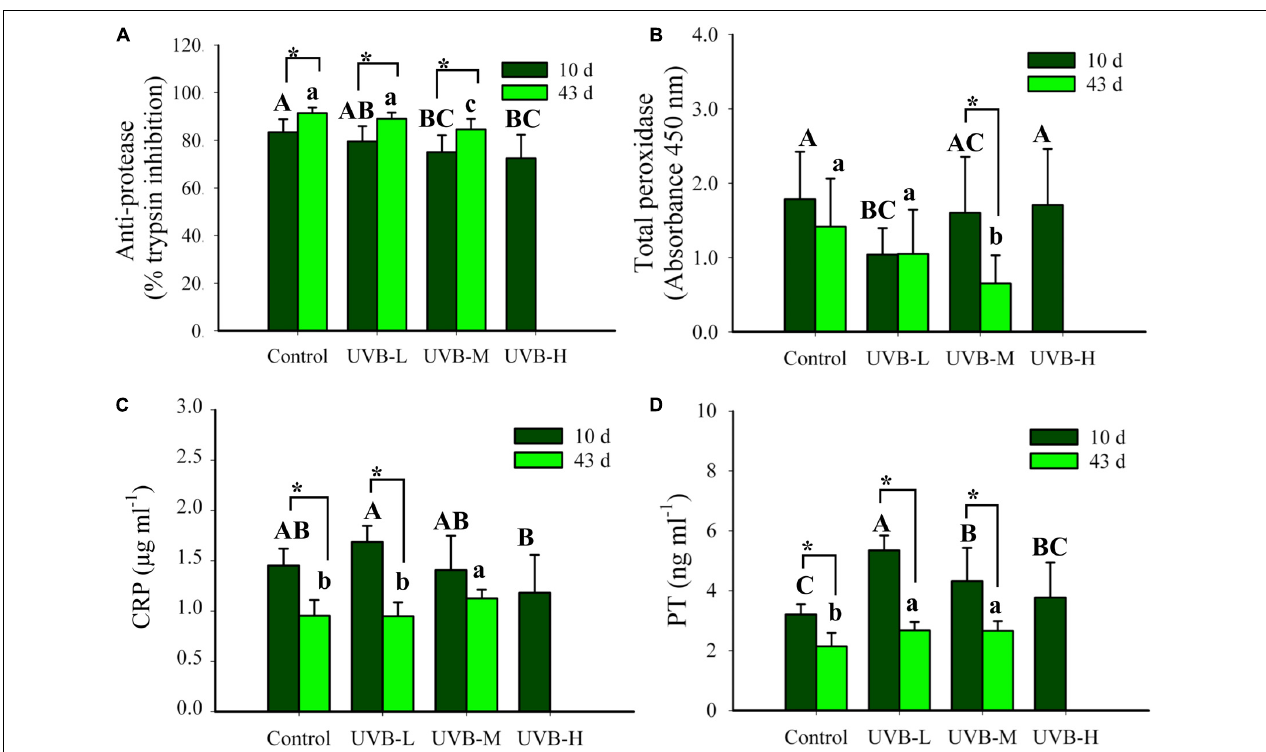
FIGURE 6 | (A) Total anti-protease activity (% trypsin inhibition), (B) total peroxidase (TP, absorbance 450 nm), (C) C reactive protein (CRP, µ g ml − 1 ), and (D) prothrombin (PT, ng ml − 1 ) in plasma of S. aurata after 10 and 43 days of exposure to UVB (total anti-protease: mean ± SD, 10 days n = 16, 43 days n = 14; total peroxidase: mean ± SD, 10 days n = 14, 43 days n = 12; CRP: mean ± SD, 10 days n = 8, 43 days n = 10; PT: mean ± SD, 10 days n = 9, 43 days n = 10). Significant differences between treatments after 10 and 43 days of UVB exposure are represented by upper and lower case letters, respectively ( P < 0.05; two-way ANOVA). Within the treatment, * indicates significant differences between 10 and 43 days of UVB exposure ( P < 0.05; two-way